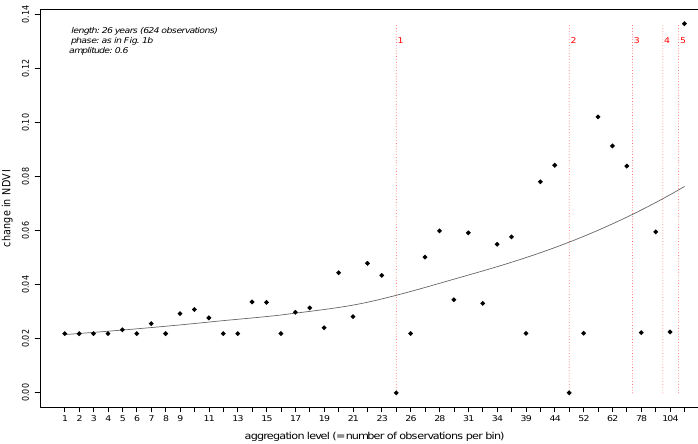
Fig. 2. Change in NDVI detected using linear models depending on the temporal aggregation level. The plot illustrates the MTUP effect for a harmonic model of 26yr (length of common AVHRR datasets) and an amplitude of 0.6 NDVI units. The points shown are the ones that resulted in a change in the number of bins, while increasing the aggregation level. The vertical dotted lines indicate aggregation levels corresponding to 1, 2, 3, 4 and 5yr respectively and the grey line shows a LOESS curve indicating an average